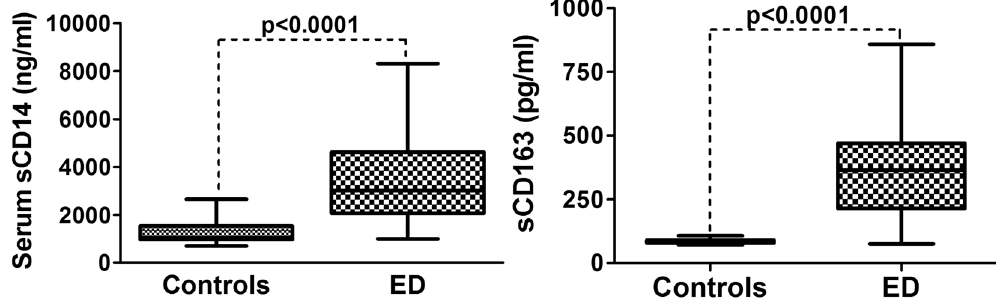
Figure 1. Box plots showed the levels of sCD14 and sCD163 in the serum of controls and excessive drinkers (ED)